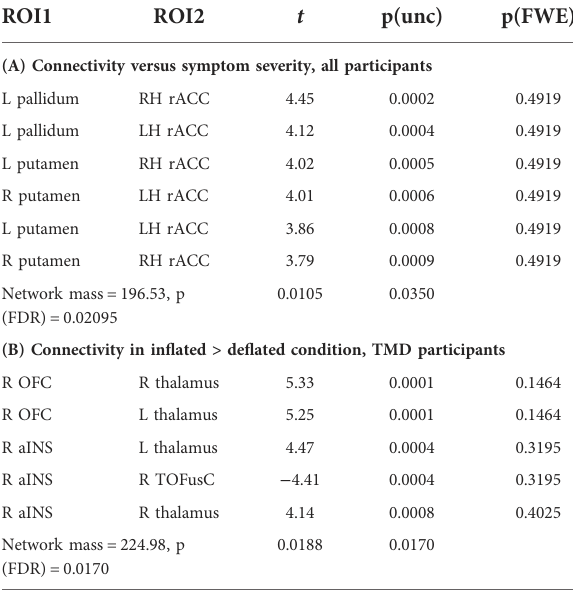
TABLE 2 Results of general linear model analyses against